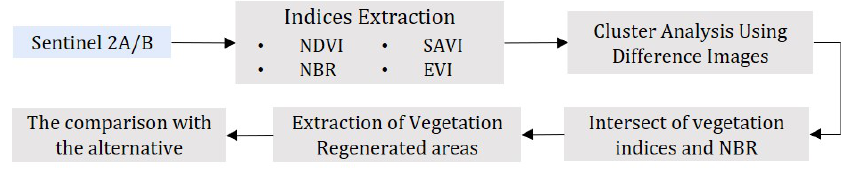
Figure 2. Flowchart of the